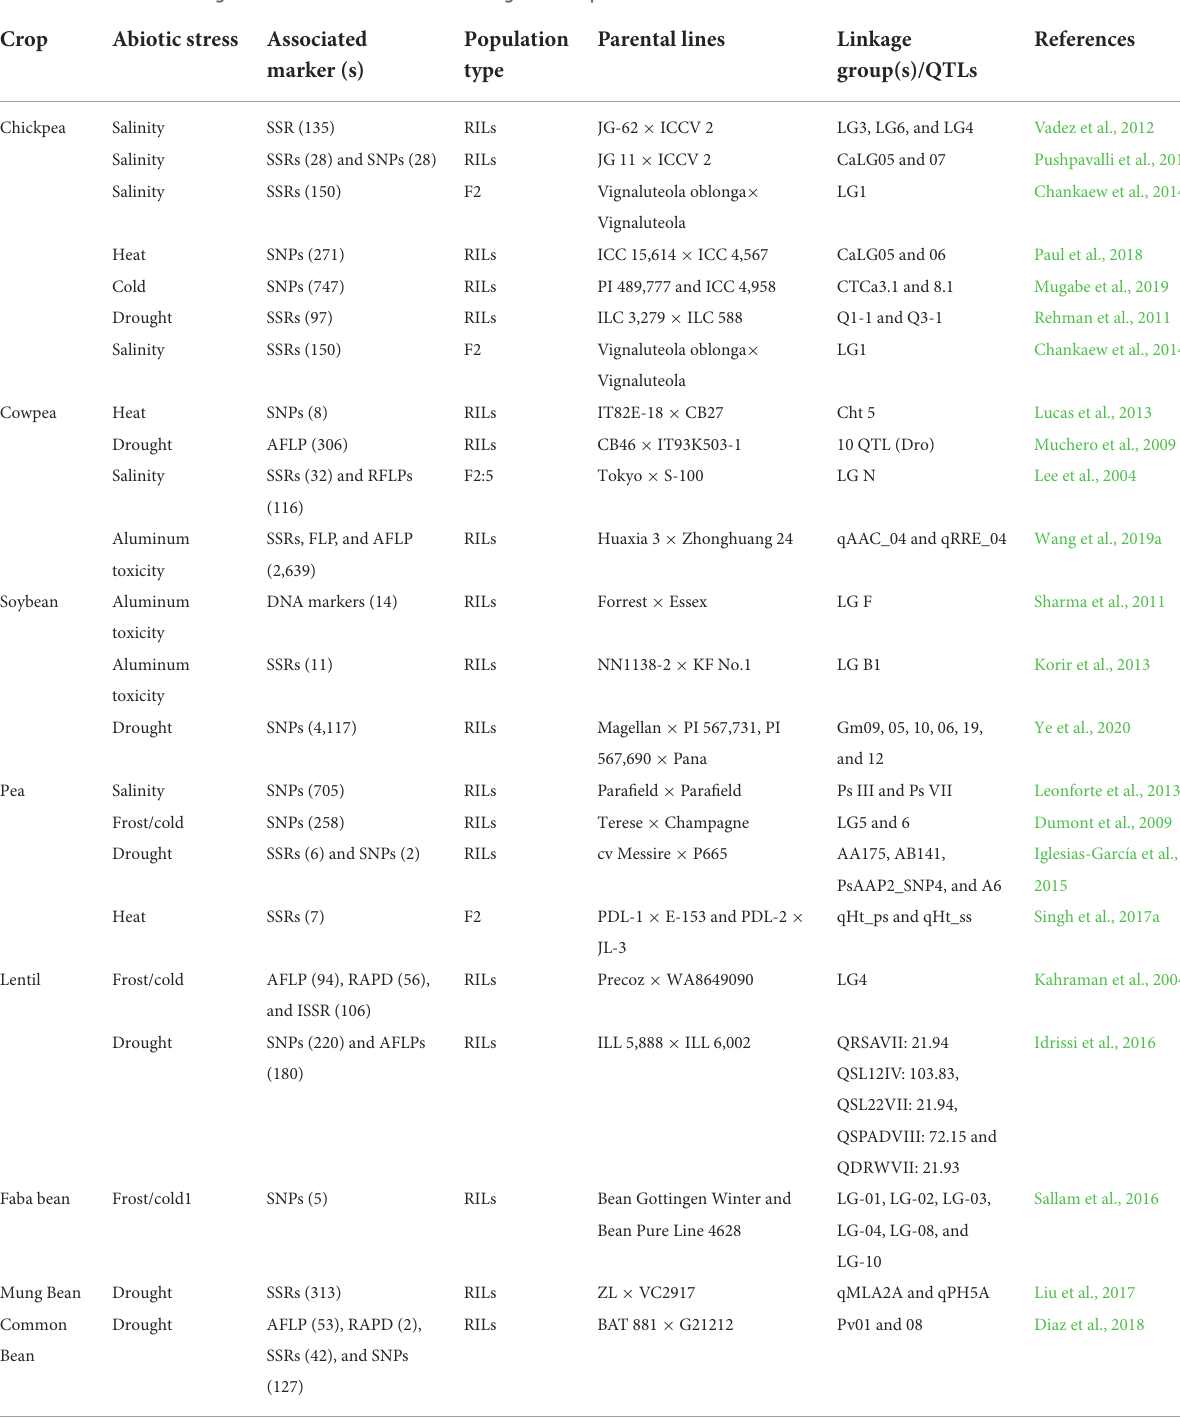
TABLE 4 QTLs identified against abiotic stresses for various legumes crops.